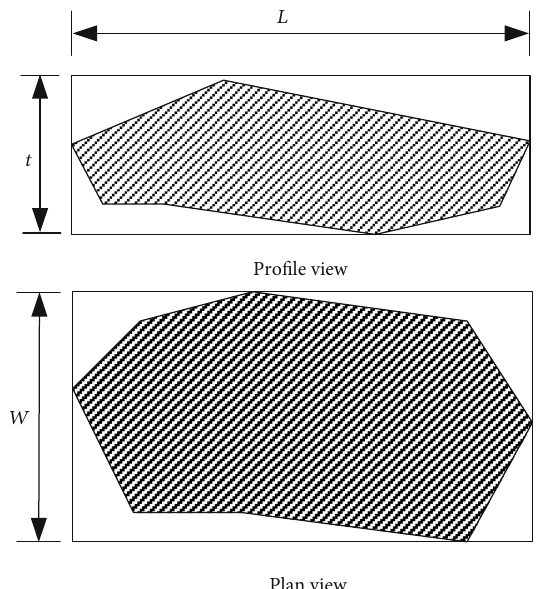
Figure 3: Plan and pro fi le views of the particles.